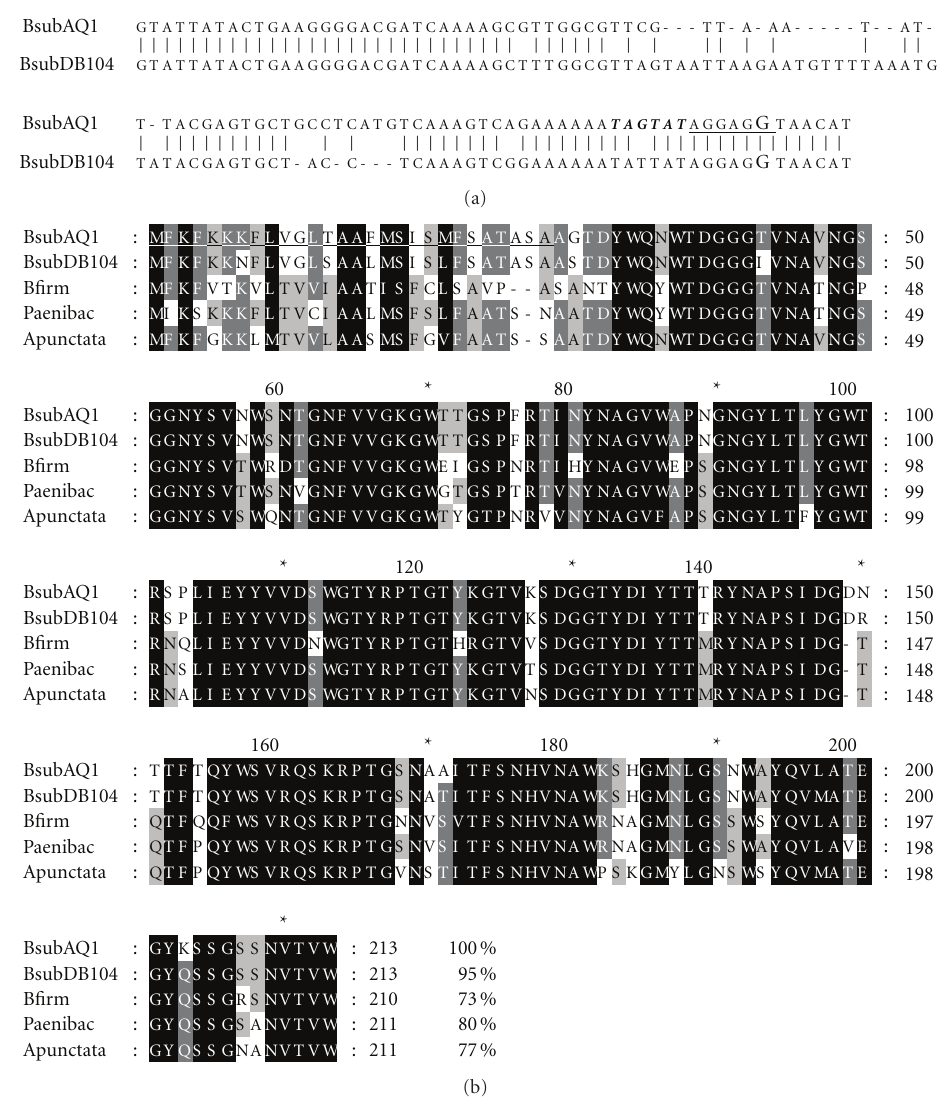
Figure 2: Alignment of AQ1 endoxylanase with other endoxylanases. (a) Comparison of putative promoter region endoxylanase gene of B. subtilis strain AQ1 and that of B.subtilis strain DB104. Underlined nucleotides correspond to the putative SD site, the large alphabet corresponds to the probable Transcription Start Site (TSS), the bold and italic nucleotides show the probable − 10 sequence (b) Alignment of AQ1 endoxylanase’s deduced amino acid (this work) with BsubDB104 from Bacillus subtilis DB104 (this work) Bfirm from Bacillus firmus (AAQ83579); Paenibac from Paenibacillus sp. ([9]; DQ869568), and Apunctata from Aeromonas Punctata (D32065). In sequence of AQ1 endoxylanase underlined amino acids constitute the putative signal